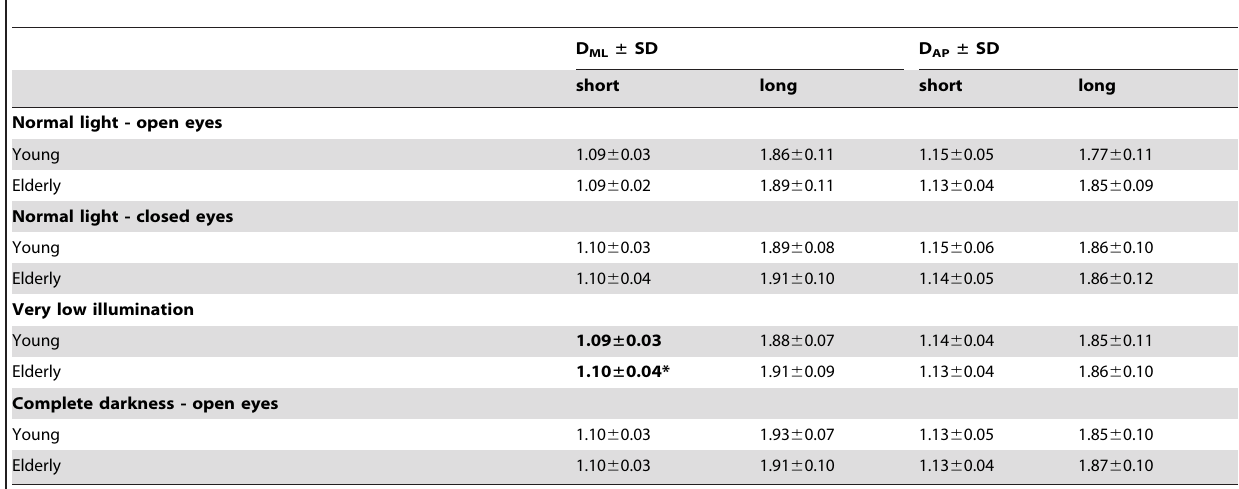
Table 3. Fractal dimensions of the medio-lateral (D ML ) and antero-posterior (D AP ) CoP time series over short (0 s to 0.3 s) and long (0.8 s to 12 s) time intervals for the 18 young and 26 elderly